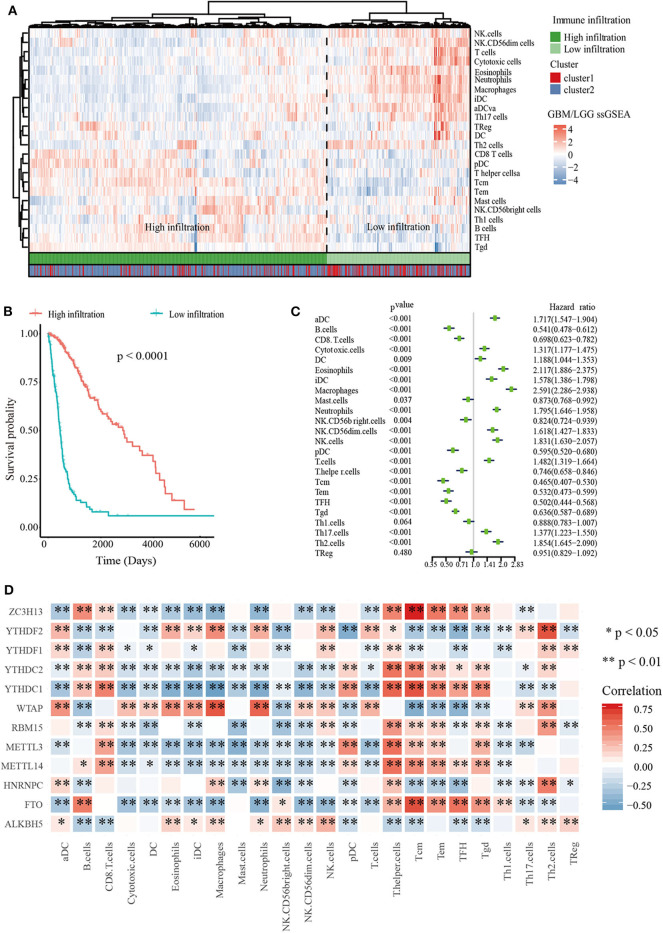
Immune landscape of glioma. (A) Heatmap of ssGSEA scores of TCGA-GBM/LGG and Table of cluster and immune infiltration subgroups (Chi-square test: X-squared = 116.63, p < 2.2e−16). (B) Kaplan–Meier overall survival (OS) curves for 665 TCGA glioma patients of different immune infiltration subgroups. (C) Forest plot for immune cells. The hazard ratios (HR), 95% confidence intervals (CI) calculated by univariate Cox regression are shown. (D) Mine plot of relationships between 12 m6A methylation regulators and 24 immune cells (*P < 0.05, **P < 0.01).